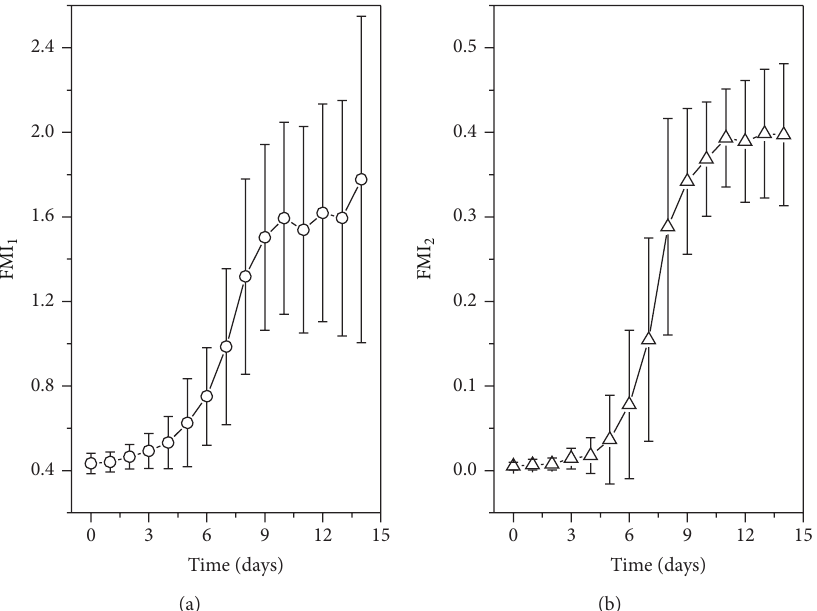
Figure 2: (a) FMI 1 and (b) FMI 2 ratio as a function of time after detachment for the FIS experiment.